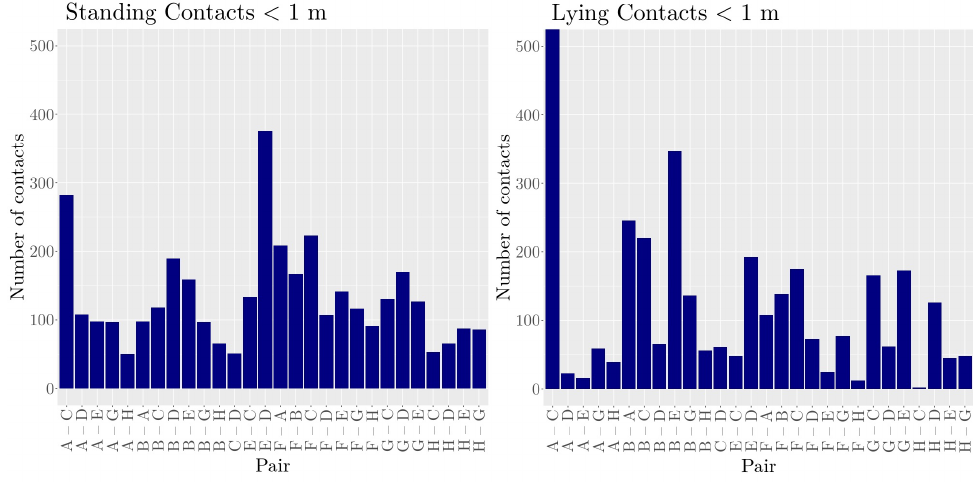
Figure 6. Number of contacts (distance < 1 m) for standing and lying animals,